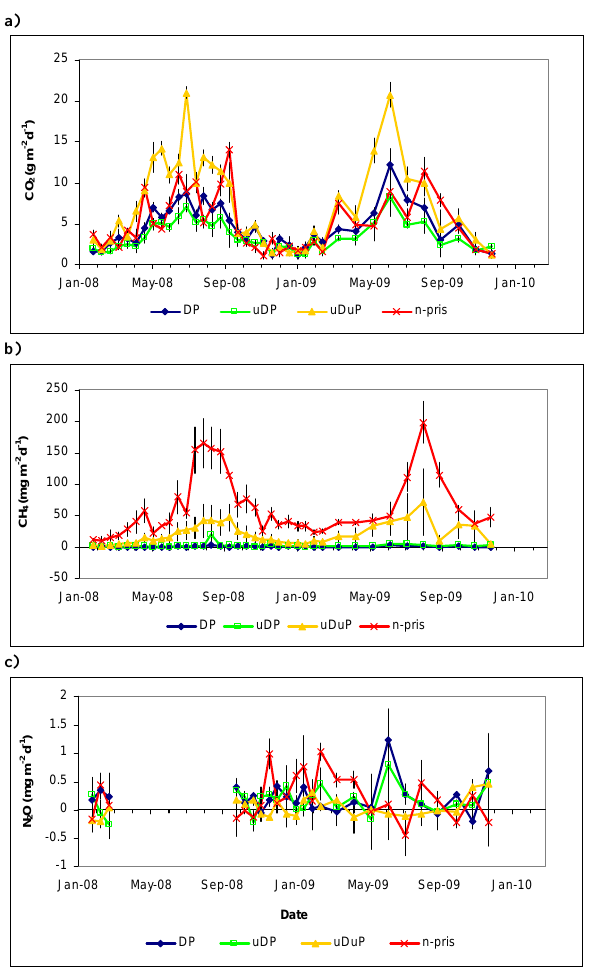
Figure 4. Fluxes of CO 2, CH 4 and N 2 O measured throughout the study period from Fig. 4. Fluxes of CO 2 , CH 4 and N 2 O measured throughout the the different treatments. Error bars for each treatment denote standard error of mean study period from the different treatments. Error bars for each calculated for replicated blocks. For FME error bars denotes differences between treatment denote standard error of mean-calculated for replicated replicated chambers. blocks. For FME error bars denotes differences between replicated chambers.